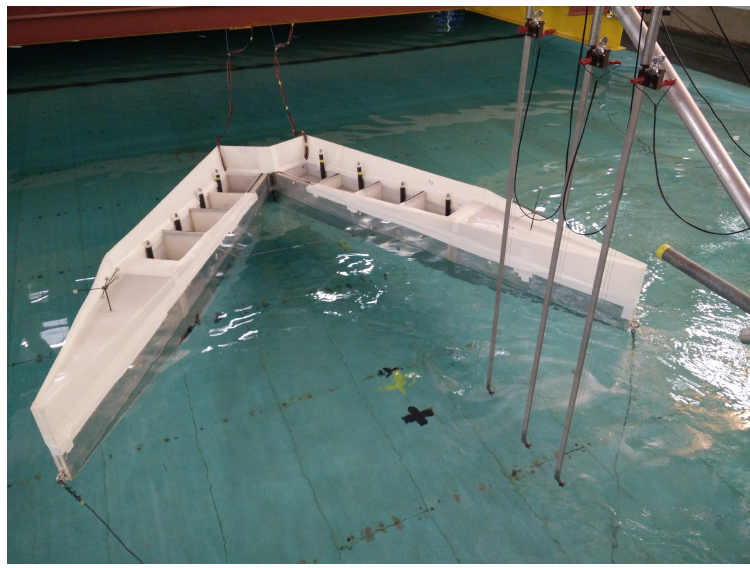
Figure 2. The 1:30 scale model constructed at the University of Plymouth in situ during